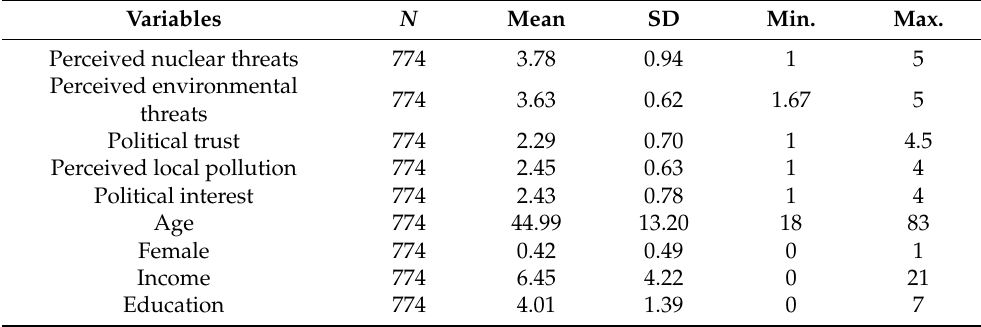
Table 1. Descriptive